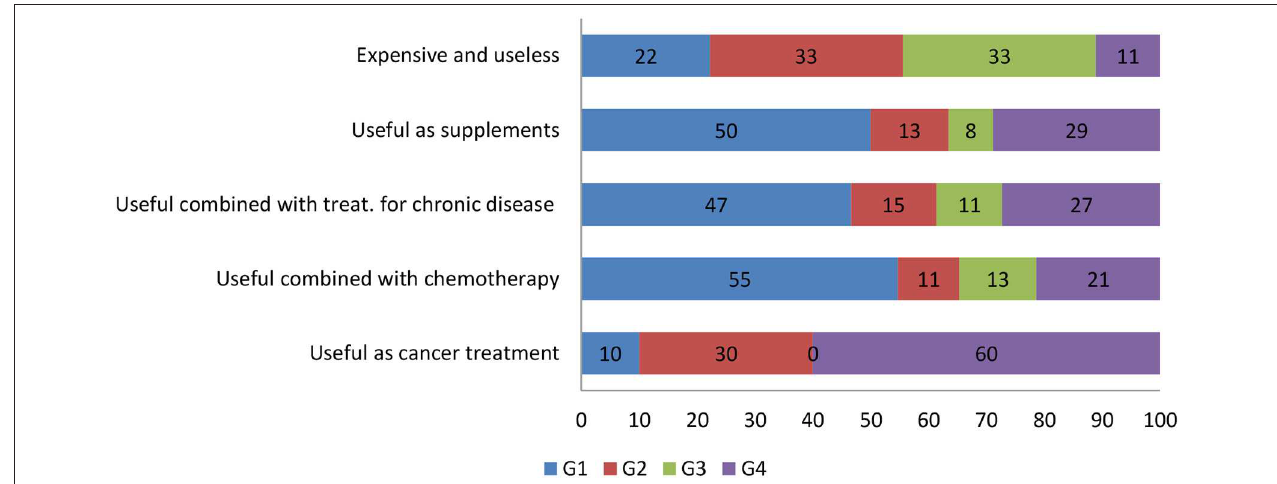
FIGURE 3 | Participants’ perception of the value of CAM interventions in relation to their specialty